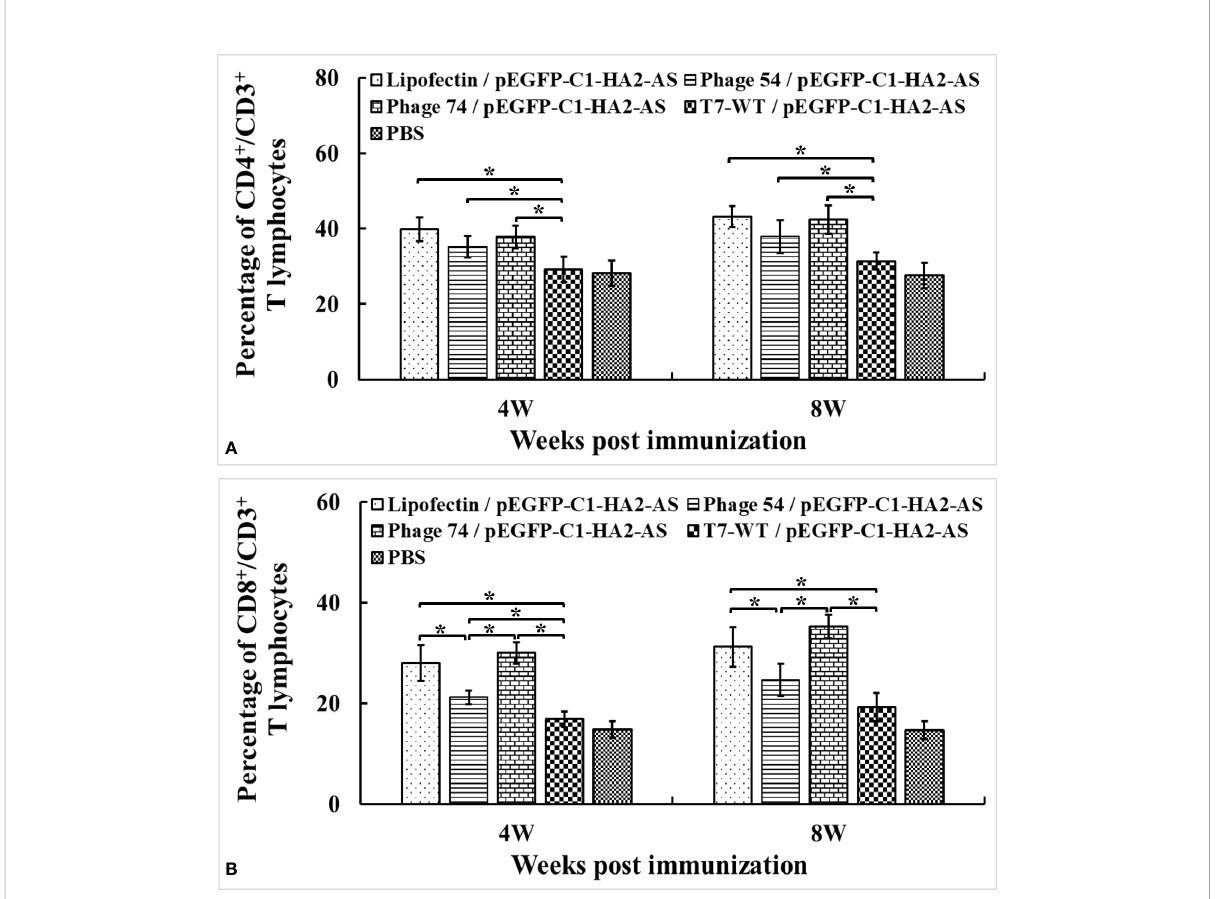
FIGURE 9 Changes of CD4 + /CD3 + (A) and CD8 + /CD3 + (B) T lymphocytes levels in peripheral blood at 4 weeks post primary and booster immunization. Values represent mean ± S.D. (n = 3). * p < 0.05 was signi fi cantly